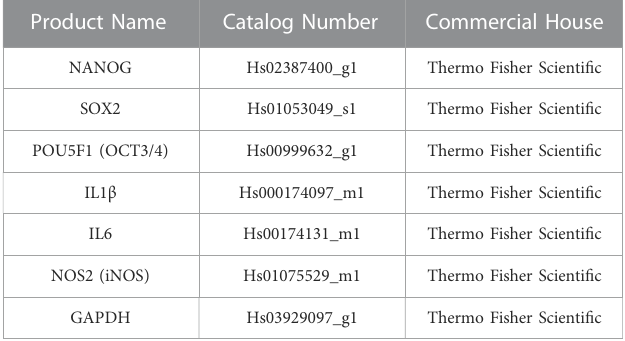
TABLE 2 Taqman assays used for gene expression analysis through